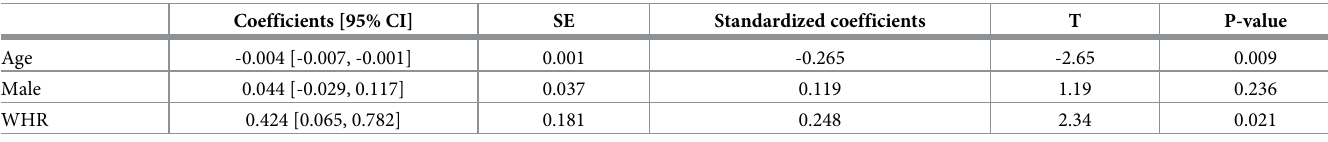
Table 4. Multiple regression analysis (30 min after the surgical